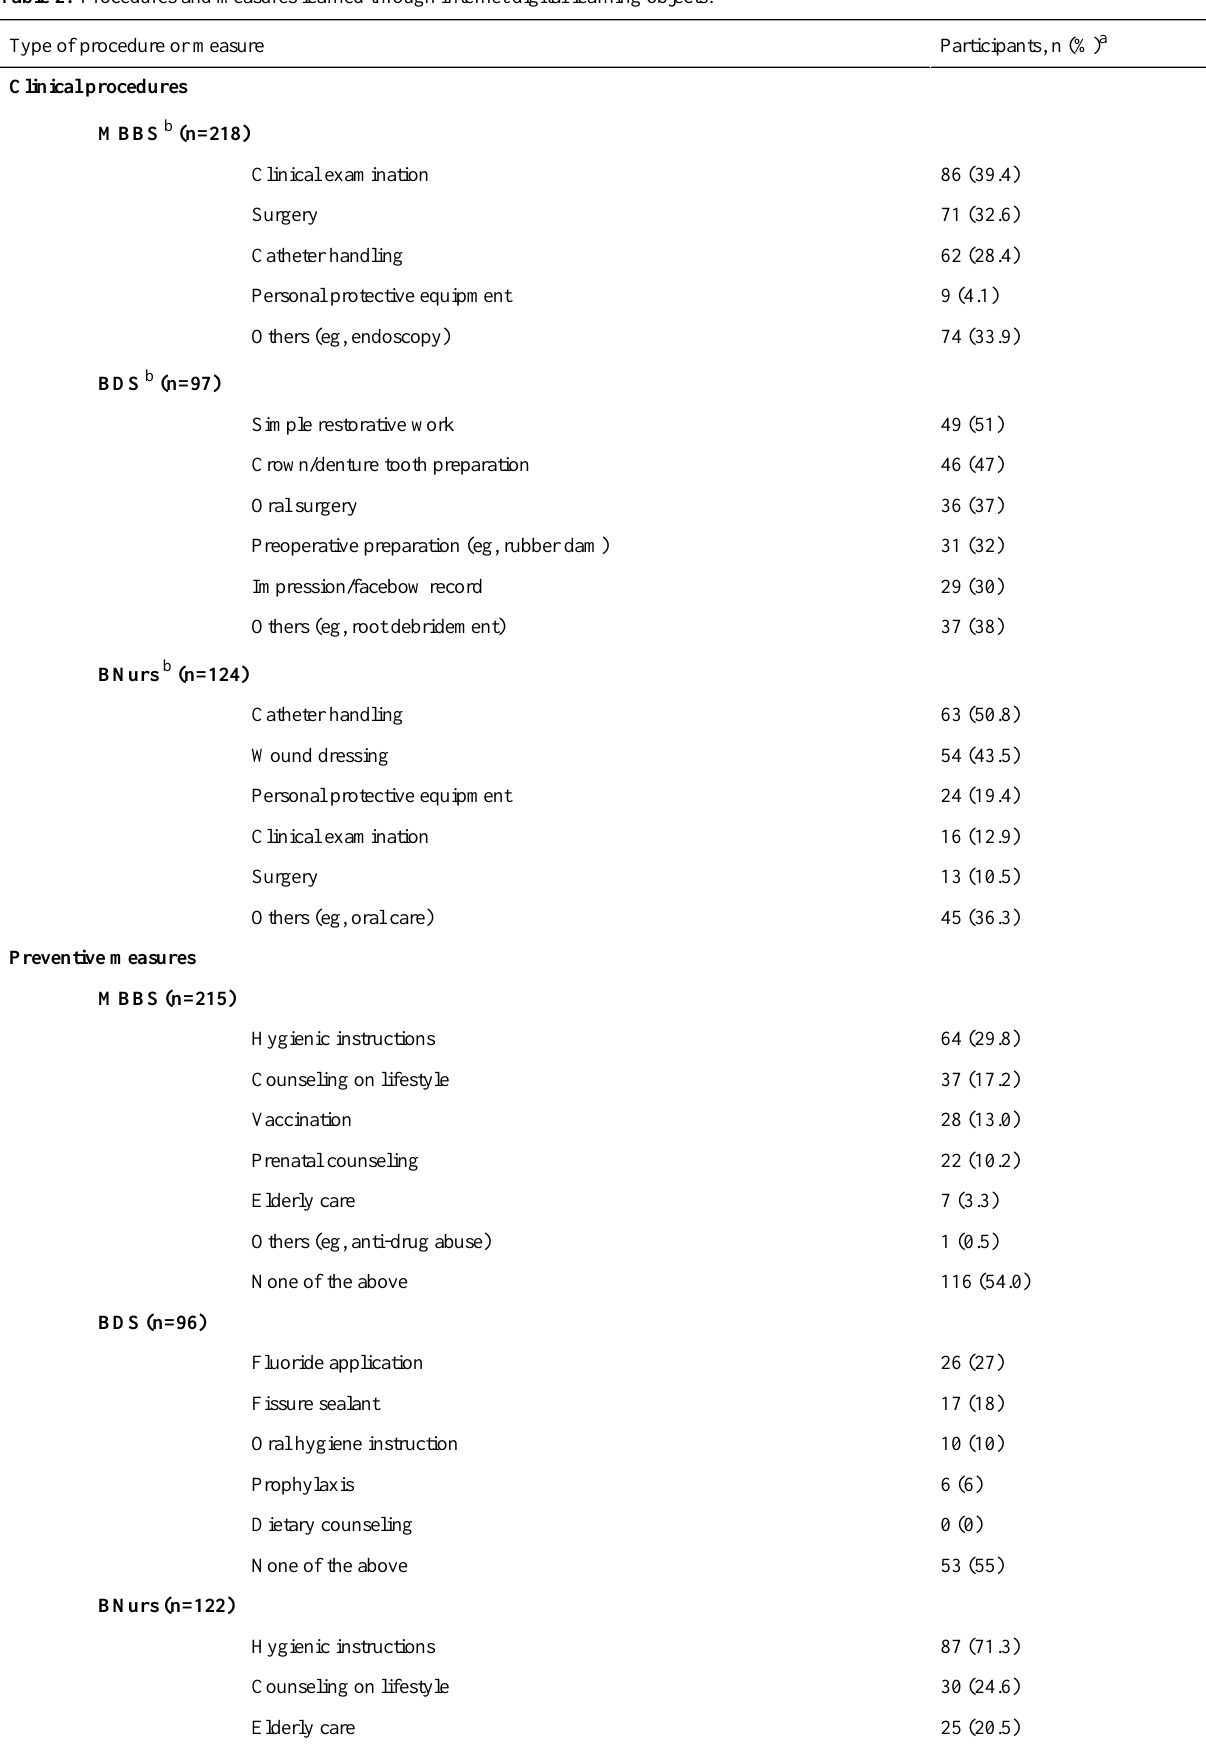
Table 2. Procedures and measures learned through Internet digital learning